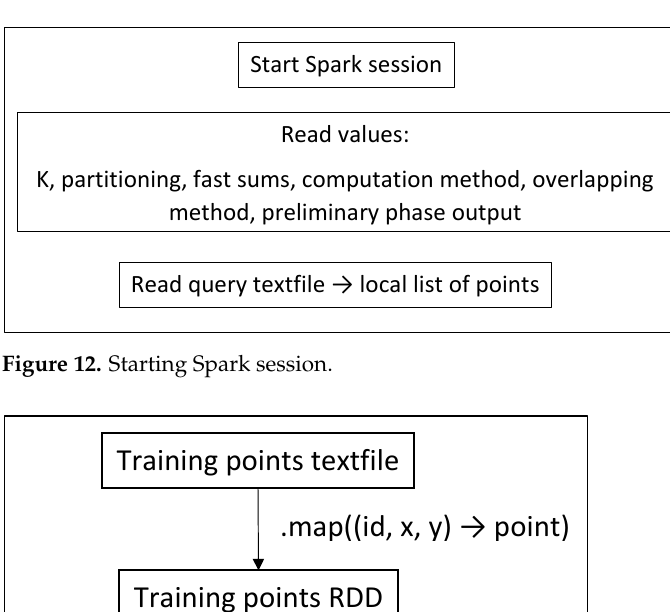
Figure 13. Create training points RDD.